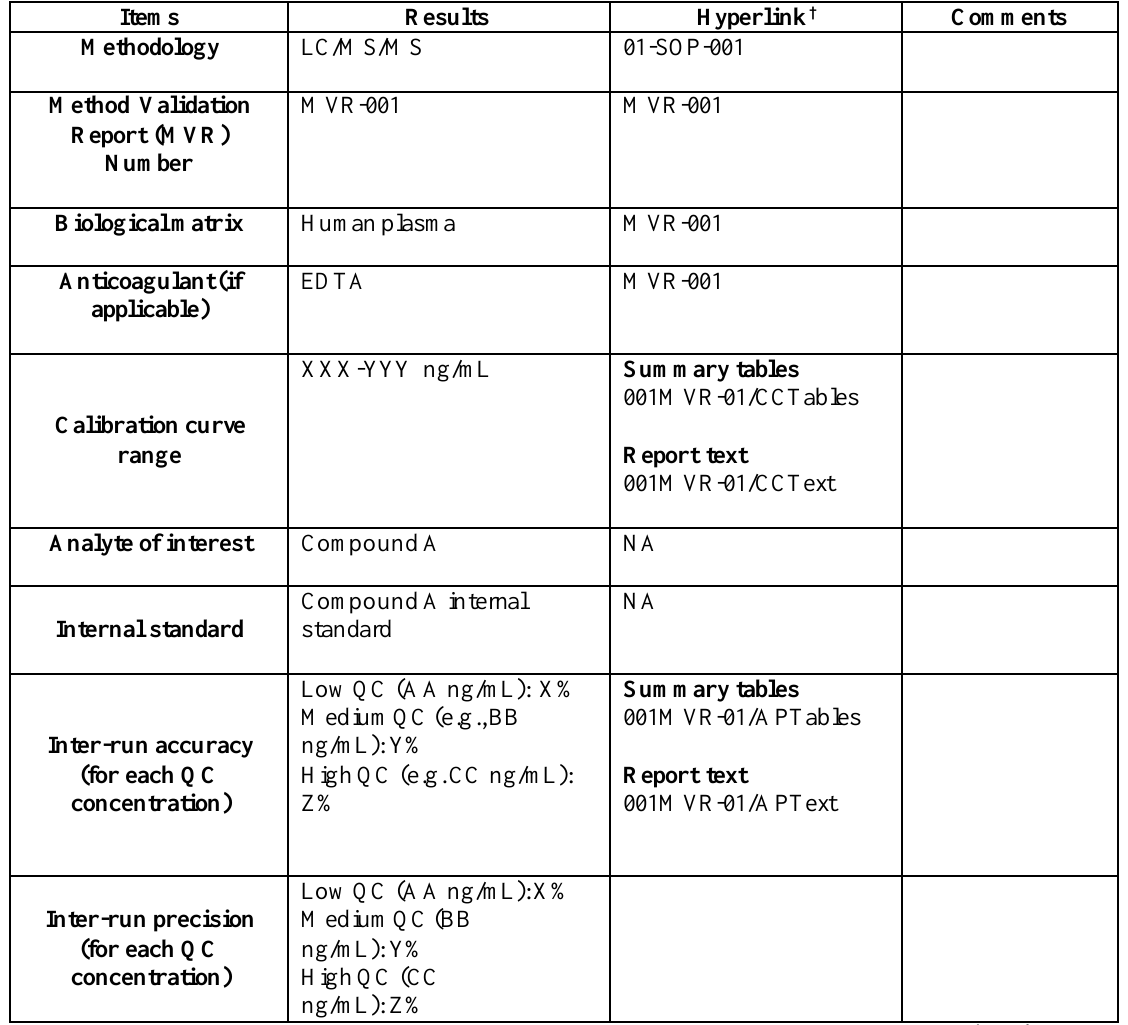
Table 3. & Example of an Overall Summary Table for a Method Validation Report* or a Clinical Study Report (this table contains fictitious information, which serves illustrative purposes